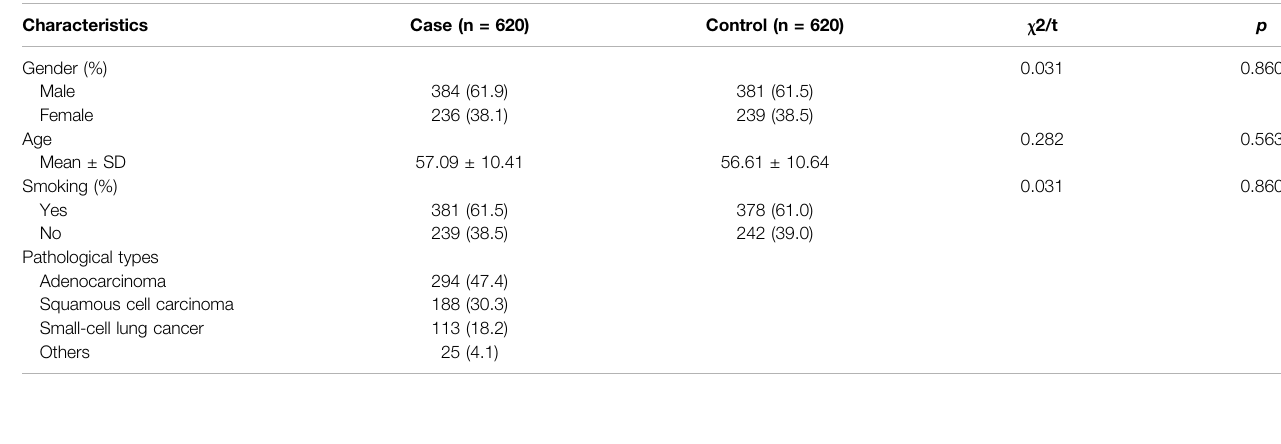
TABLE 2 | Basic information and predicted functions of candidate SNPs.